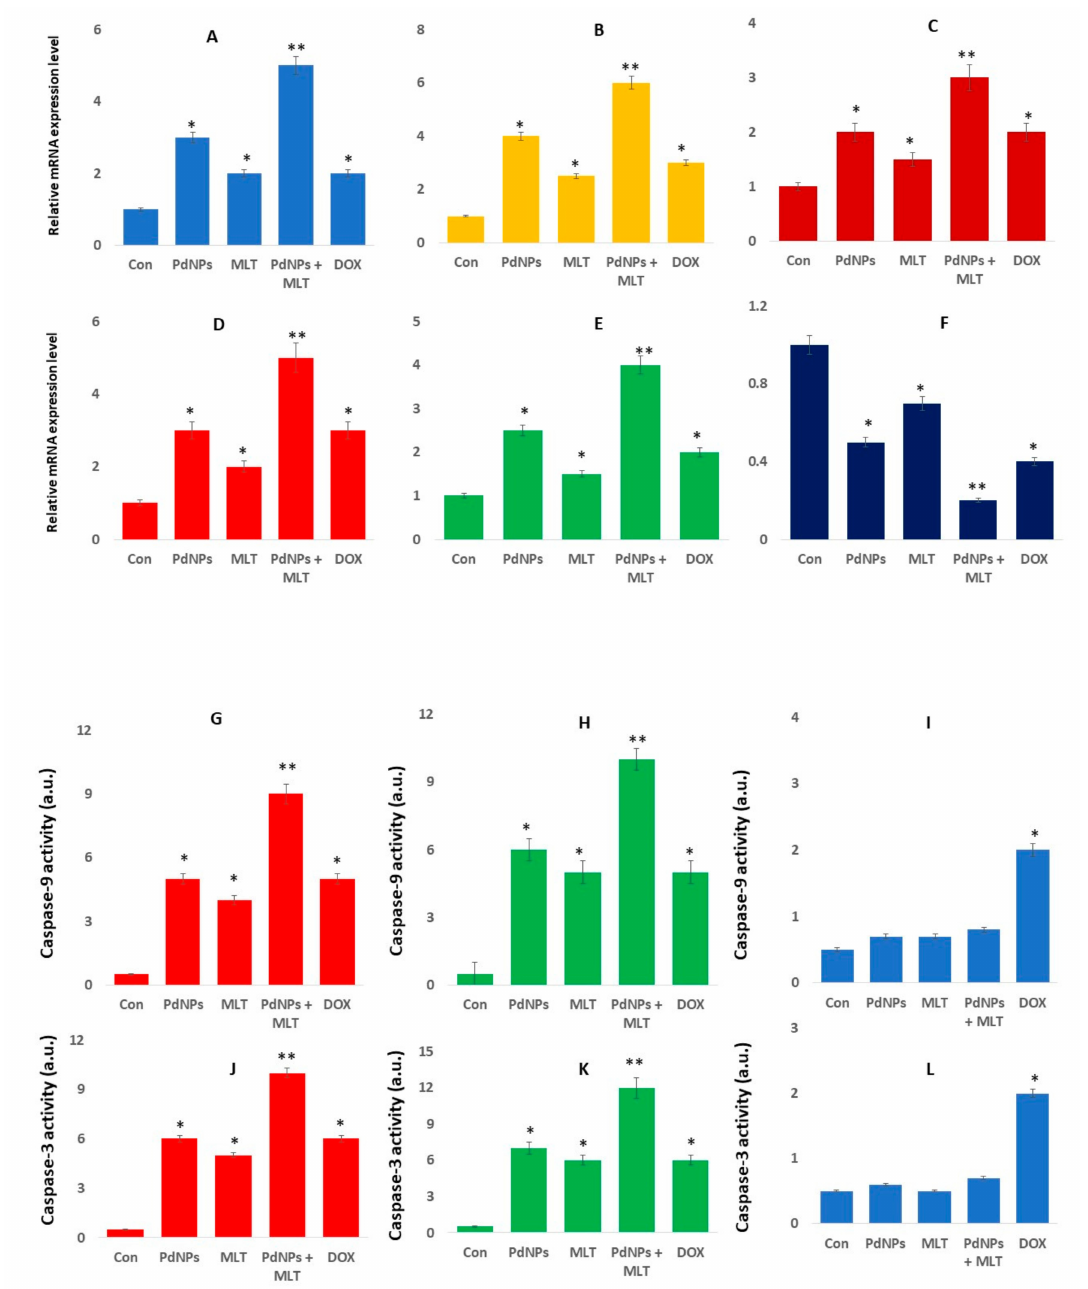
Figure 10. PdNPs + MLT increased the expression of apoptotic genes. The mRNA expression of the apoptotic genes ( A ) p53 ( B ), p21 ( C ), Cyt C , ( D ) caspase-3 ( E ) Bax , and ( F ) Bcl-2 . The fold change in the expression was determined relative to GAPDH expression. Caspase 9 activity was determined in A549 human lung cancer cells ( G ), H1229 ( H ), and L132 normal human cells ( I ). Caspase 3 activity was determined in A549 human lung cancer cells ( J ), H1229 ( K ), and L132 normal human cells ( L ). The concentration of the p -nitroaniline released from the substrate was calculated from the absorbance values at 405 nm. Results are shown as the mean ± standard deviation of three independent experiments. Student’s t -test revealed a significant di ff erence between treated and untreated cells (* p < 0.05) and between the treated and control cells. * p < 0.05 was considered significant; ** p < 0.01 was considered highly